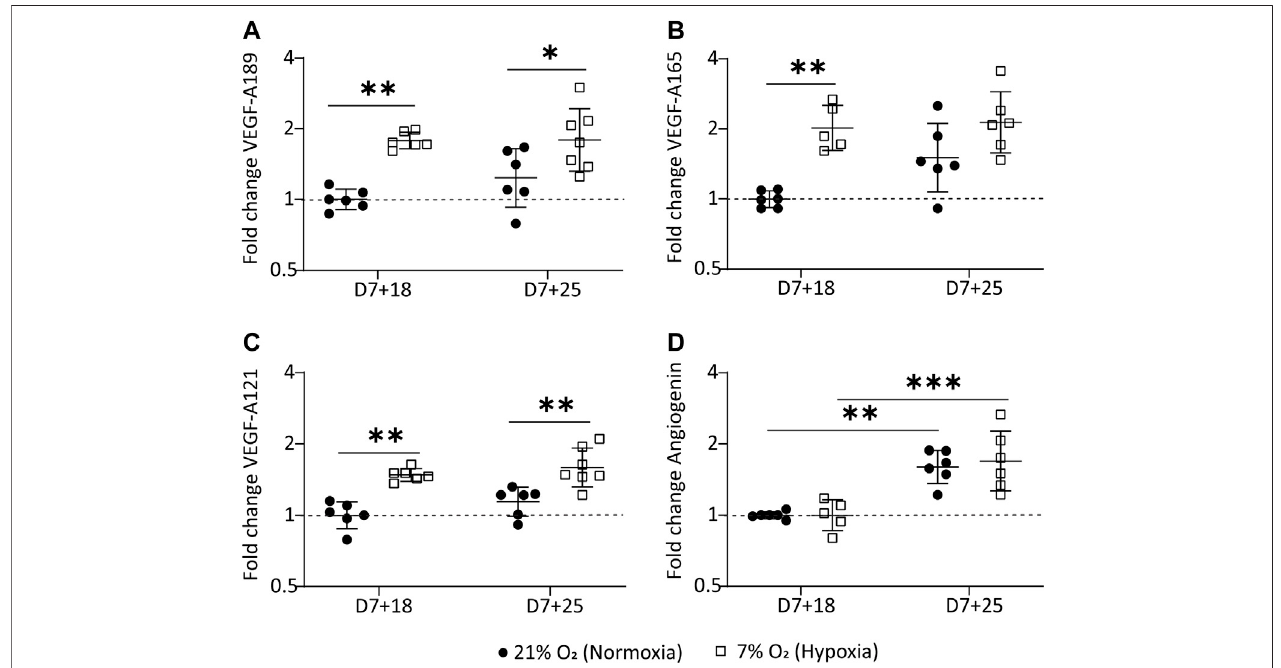
FIGURE 5 | Hypoxic organoid culture differentially regulates VEGF-A variants. (A) . VEGF-189 is signi fi cantly upregulated at both time points in the hypoxic culture. (B) . VEGF-A165 is signi fi cantly upregulated at day 7+18 in the hypoxic culture and (C) . VEGF-121 is signi fi cantly upregulated at both time points in the hypoxic culture. (D) . Angiogenin mRNA is signi fi cantly upregulated over time in both the normoxic and hypoxic culture. The data is plotted relative to day 7+18 normoxia (n=3, N=3 with excluded technical failures). *= p ≤ 0.03, ** = p ≤ 0.002, *** = p ≤